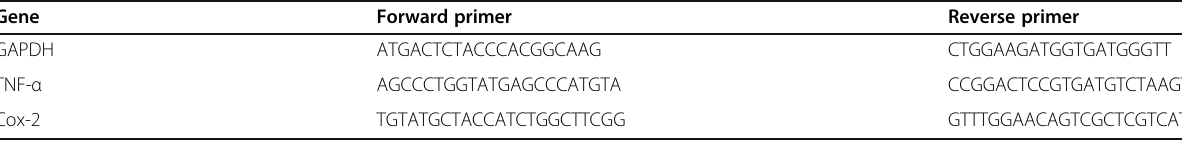
Table 1 List of the primers used in the real time quantitative PCR method Gene Forward primer Reverse primer GAPDH ATGACTCTACCCACGGCAAG TNF-